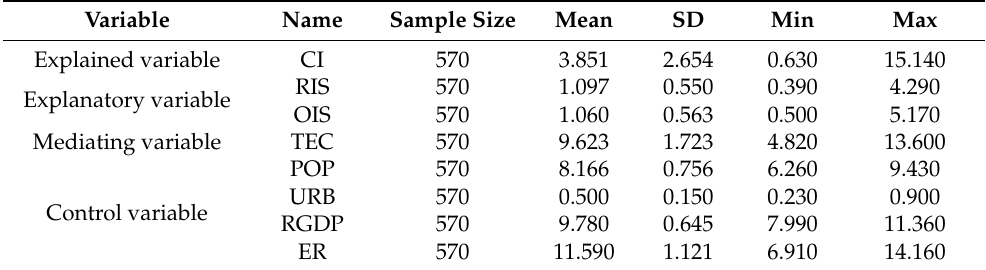
Table 2. The descriptive statistics of variables.